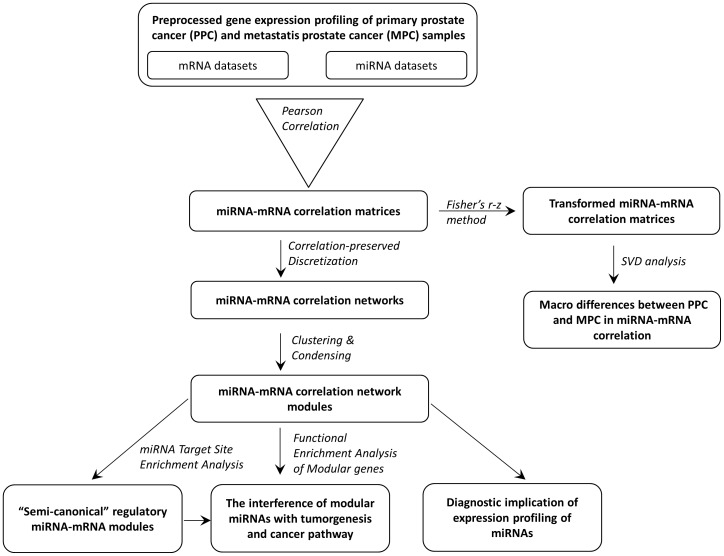
The schematic presentation of the study flow.